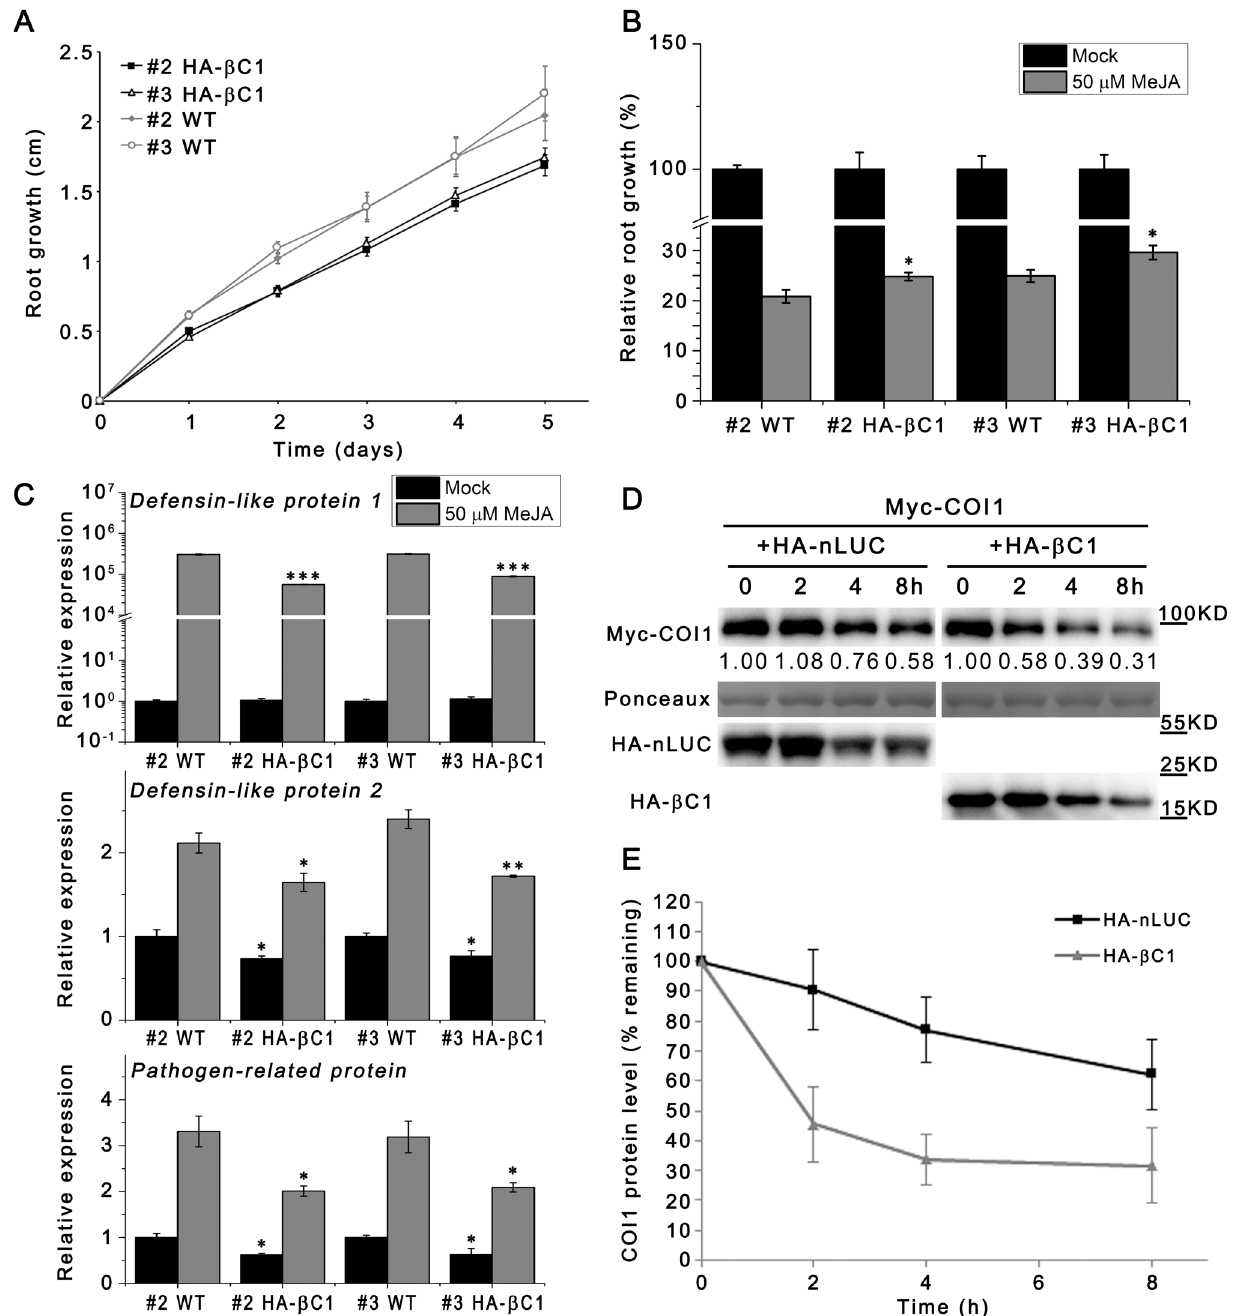
Fig 6. CLCuMuB β C1 represses JA responses though interfering with the integrity of SCF COI1 . (A) Total root length of HA- β C1 transgenic (#2 HA- β C1 and #3 HA- β C1) and wild-type (#2 WT and #3 WT) N . benthamiana seedlings was measured every 24 h beginning at the 6th day after sowing (n (cid:1) 11). Bars represent SEM. #2 HA- β C1 and #2 WT were presented on same plates, while #3 HA- β C1 and #3 WT were presented on same plates. These experiments were repeated 3 times. (B) Jasmonate sensitivity was measured as root growth inhibition. Six-day-old seedlings (n (cid:1) 10) were grown on MS contained with 50 μ M MeJA for additional 4 days. Bars represent SEM. The raw data were analysed by Mann-Whitney rank sum test to show the significance level at 0.05 ( * ). (C) Relative expression level of marker genes of jasmonate responses in mock- or MeJA-treated HA- β C1 transgenic and wild-type N . benthamiana seedlings determined by quantitative real-time PCR. #2 HA- β C1 and #2 WT were presented on same plates, while #3 HA- β C1 and #3 WT were presented on same plates. HA- β C1-expressing lines are compared with their corresponding control in each condition. Actin was used as the internal control. Bars represent SEM. The raw data were analysed by two-sample t -test to show the significance level at 0.05 ( * ), 0.01 ( ** ) and 0.001 ( *** ). These